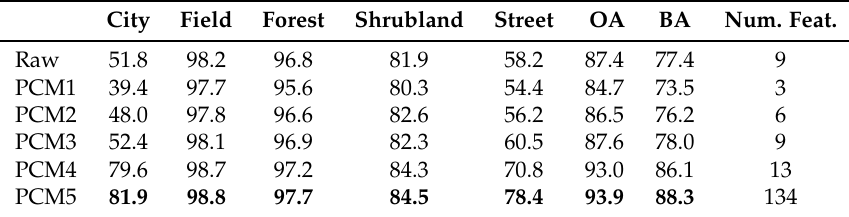
Table 2. Summary of the classification results (in percent) for PolSAR CM features. Best accuracies are indicated in bold font.